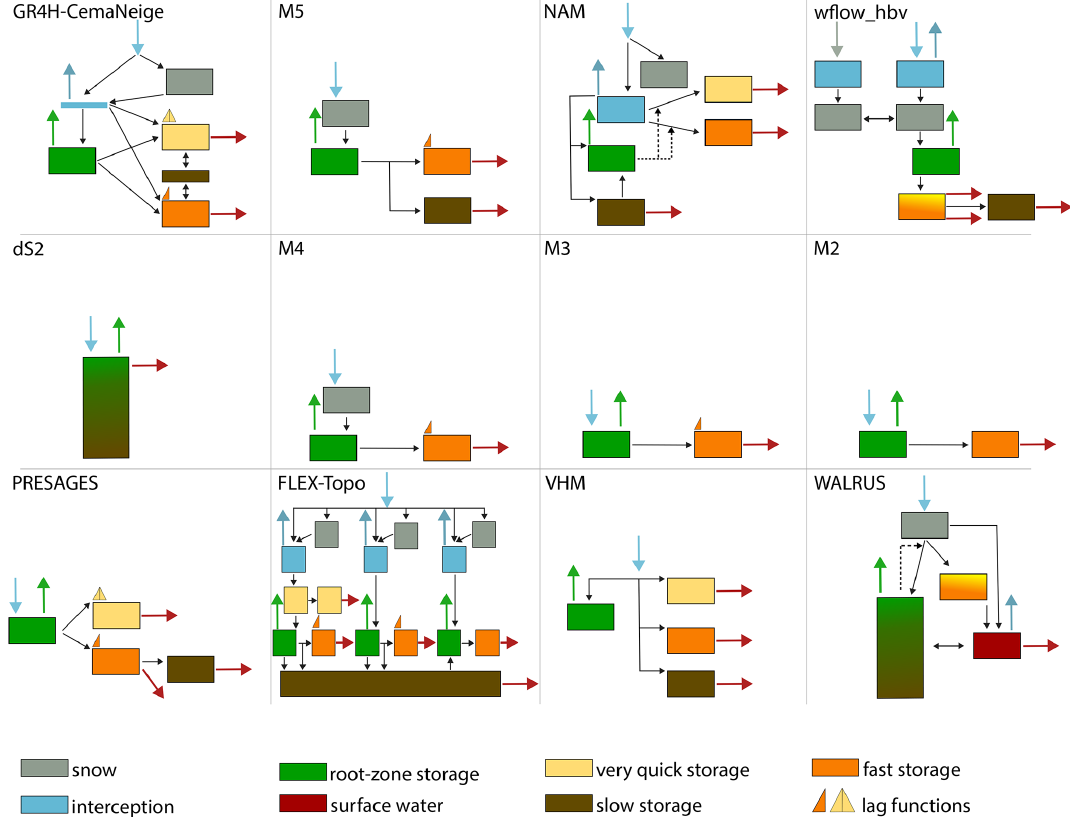
Figure 2. Simplified schematic overview of 12 model structures (adapted from de Boer-Euser et al., 2017) with the aim of highlighting similarities and differences between the models. Solid arrows indicate fluxes between stores, while dashed arrows indicate the influence of a state on a flux. Colored arrows indicate incoming or outgoing fluxes, whereas black arrows indicate internal fluxes. The narrow blue rectangle in GR4H indicates the presence of an interception module without interception storage capacity (Table 3). Storages with a color gradient indicate the combination of several components in one reservoir. FLEX-Topo consists of three hydrological response units connected through a shared slow reservoir, and wflow_hbv is a distributed